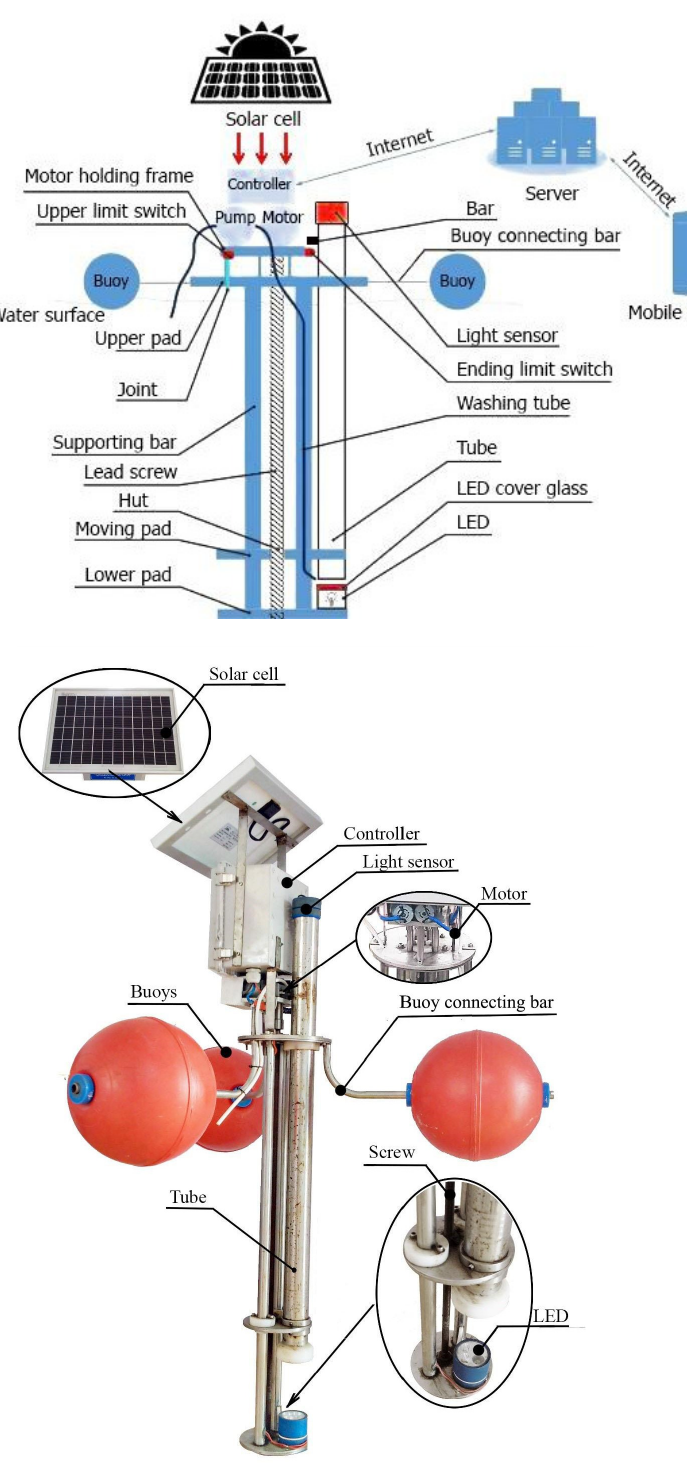
Figure 2. Design of our proposed instrument and its real